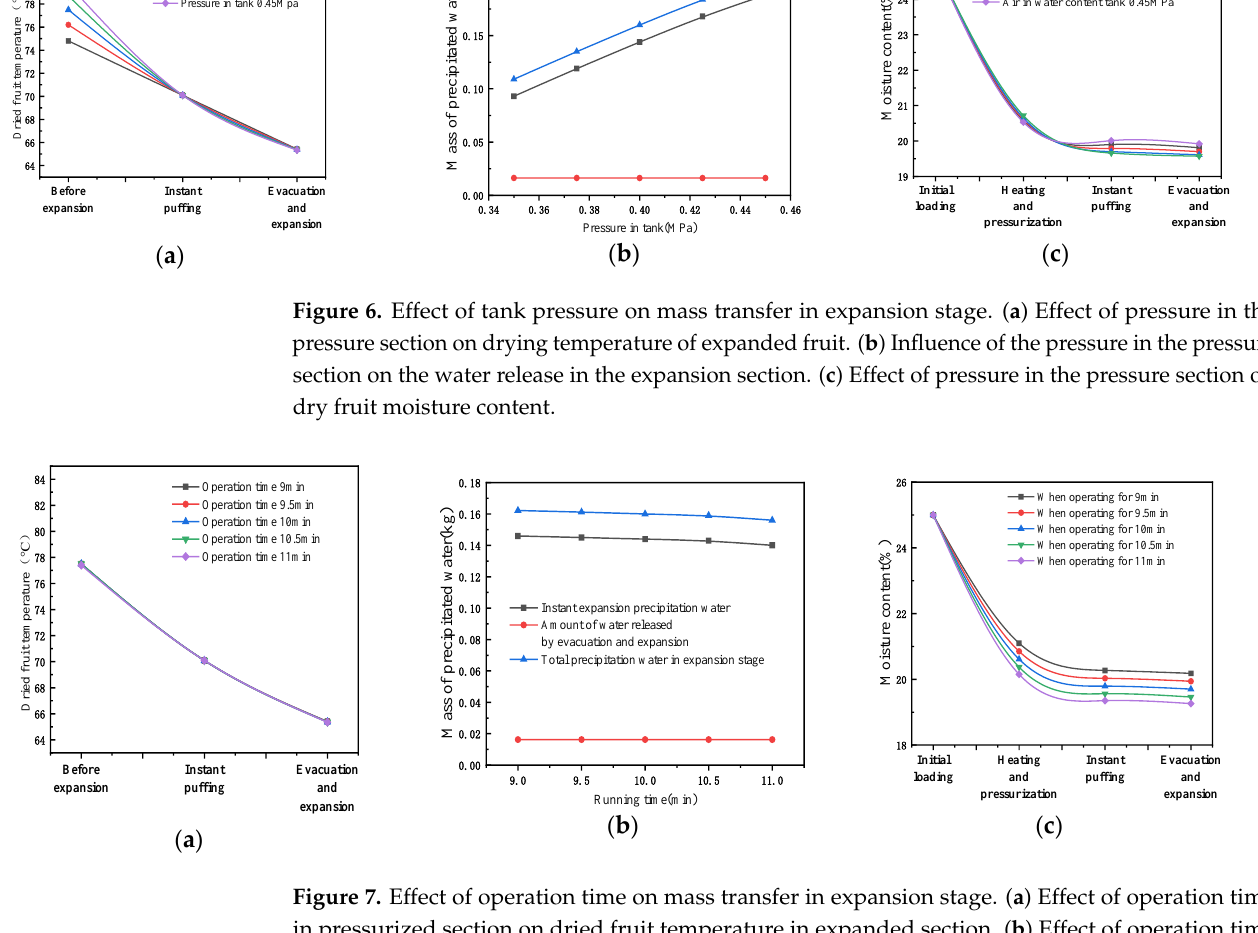
Figure 7. Effect of operation time on mass transfer in expansion stage. ( a ) Effect of operation time in pressurized section on dried fruit temperature in expanded section. ( b ) Effect of operation time in pressurized section on water precipitation in expanded section. ( c ) Effect of operation time in pressurized section on moisture content of dried fruit.